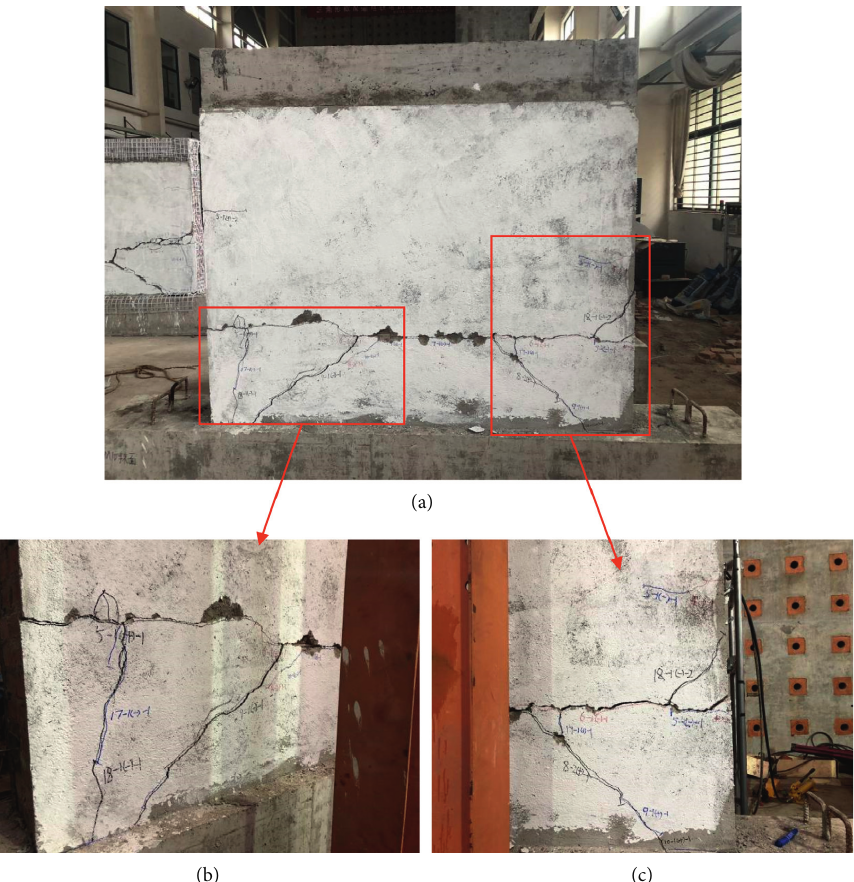
Figure 7: Damage mode of unstrengthened specimen W-2. (a) Overall damage, (b) damage in the bottom left corner, and (c) damage in the bottom right